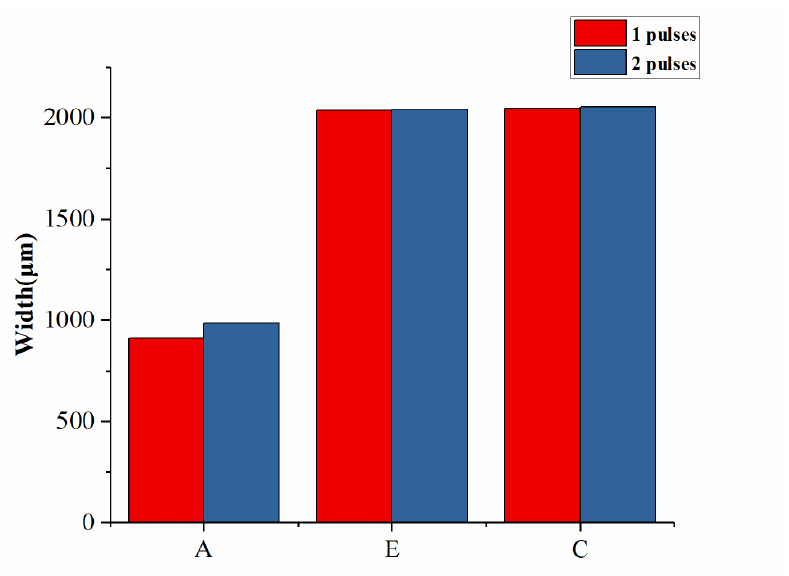
Figure 10. Dimensions A, E, and C of joints with two different numbers of laser pulses.